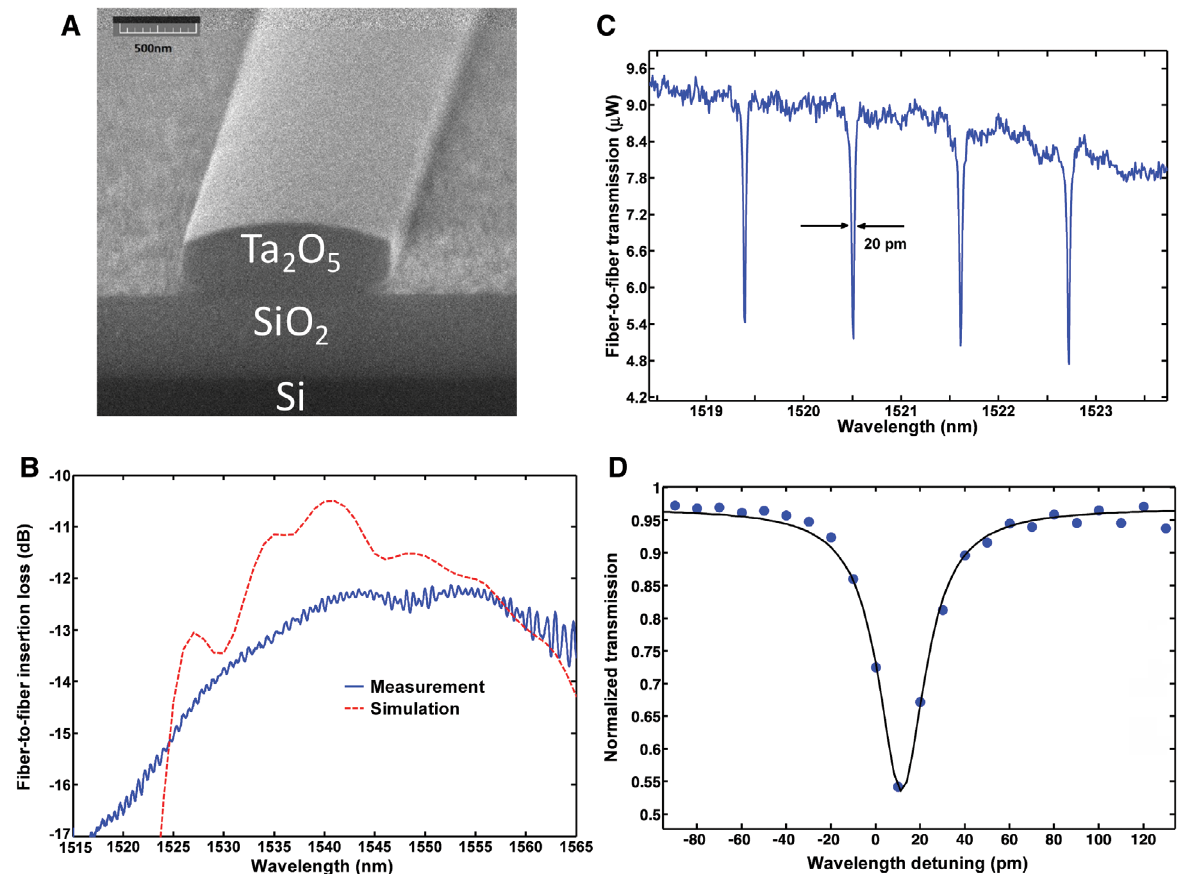
O waveguides on Si; (B) measured and simulated transmission spectrum of grating couplers on the plat- Figure 7 (A) Microigraph of Ta 2 5 form; (C) measured spectral response of the microring resonators fabricated on the platform in the 1550 nm range; (D) zoomed version